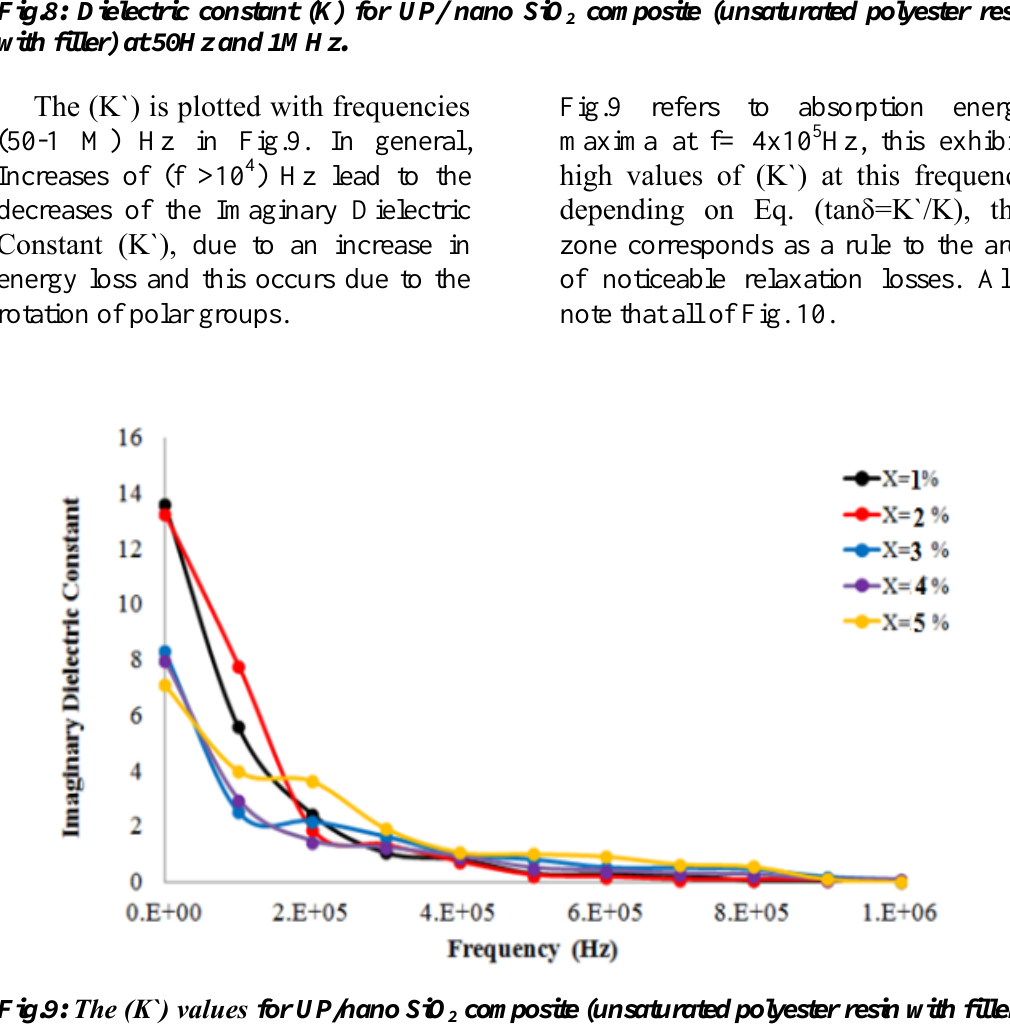
composite (unsaturated polyester resin with 2